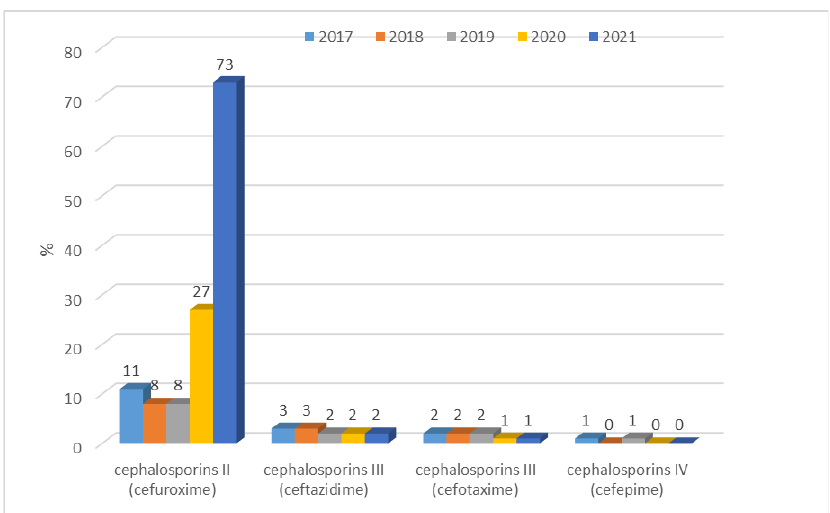
Figure 5. Percentage of cephalosporin-resistant E. coli ESBL(−) strains.